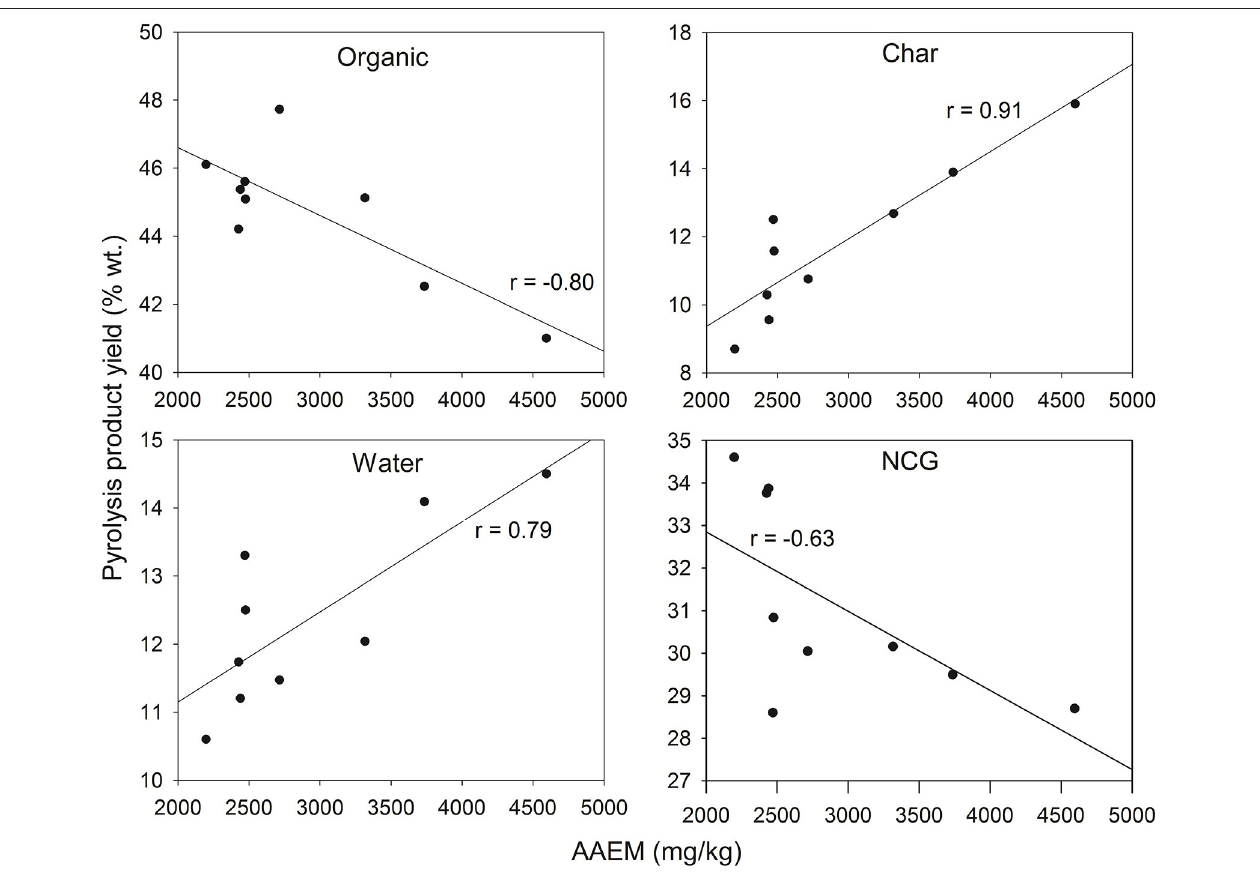
FIGURE 6 | Plots showing the correlation between the AAEM and the pyrolysis product yields of organic phase bio-oil “Organic,” biochar, water, and non-condensable gases “NCG.” AAEM was calculated as the sum of Ca, K, Mg, and